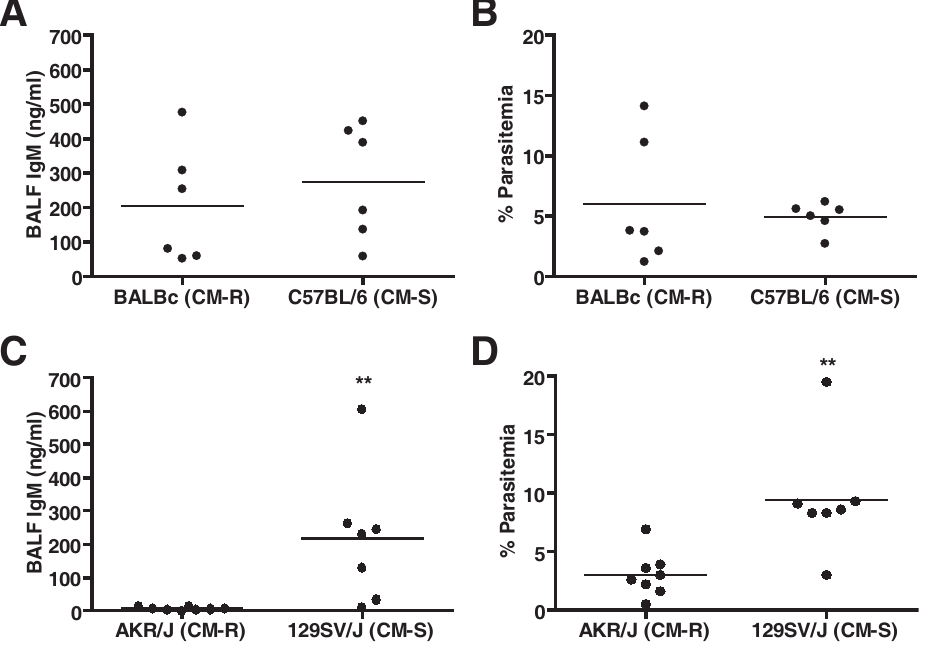
Figure 5. PbA-induced ALI does not correlate with CM susceptibility in in-bred mouse strains. Two pairs of CM-resistant and CM- susceptible mouse strains were infected with PbA to examine whether genetic susceptibility to CM in the PbA model parallels susceptibility to ALI. A. Despite different infection outcome, C57BL/6 (CM-susceptible, n=6) and BALB/c (CM-resistant, n=6) mice have equivalent BALF IgM day 6 (horizontal lines represent mean), increased over uninfected controls, and also have equivalent parasitemia ( B ; geometric means C57BL/6=4.78 and BALBc=4.21). C. Conversely, 129SV/J (CM-susceptible, n=7) mice develop significantly higher levels of BALF IgM (horizontal line represents mean, 2- tailed t-test, p=0.0104) and also show significantly higher parasitemia than AKR/J (CM-resistant, n=8) mice ( D ; horizontal line represents geometric mean, Mann-Whitney U test p=0.0022). Both data sets are representative of two independent experiments. These results indicate that genetic susceptibility to CM does not correspond to